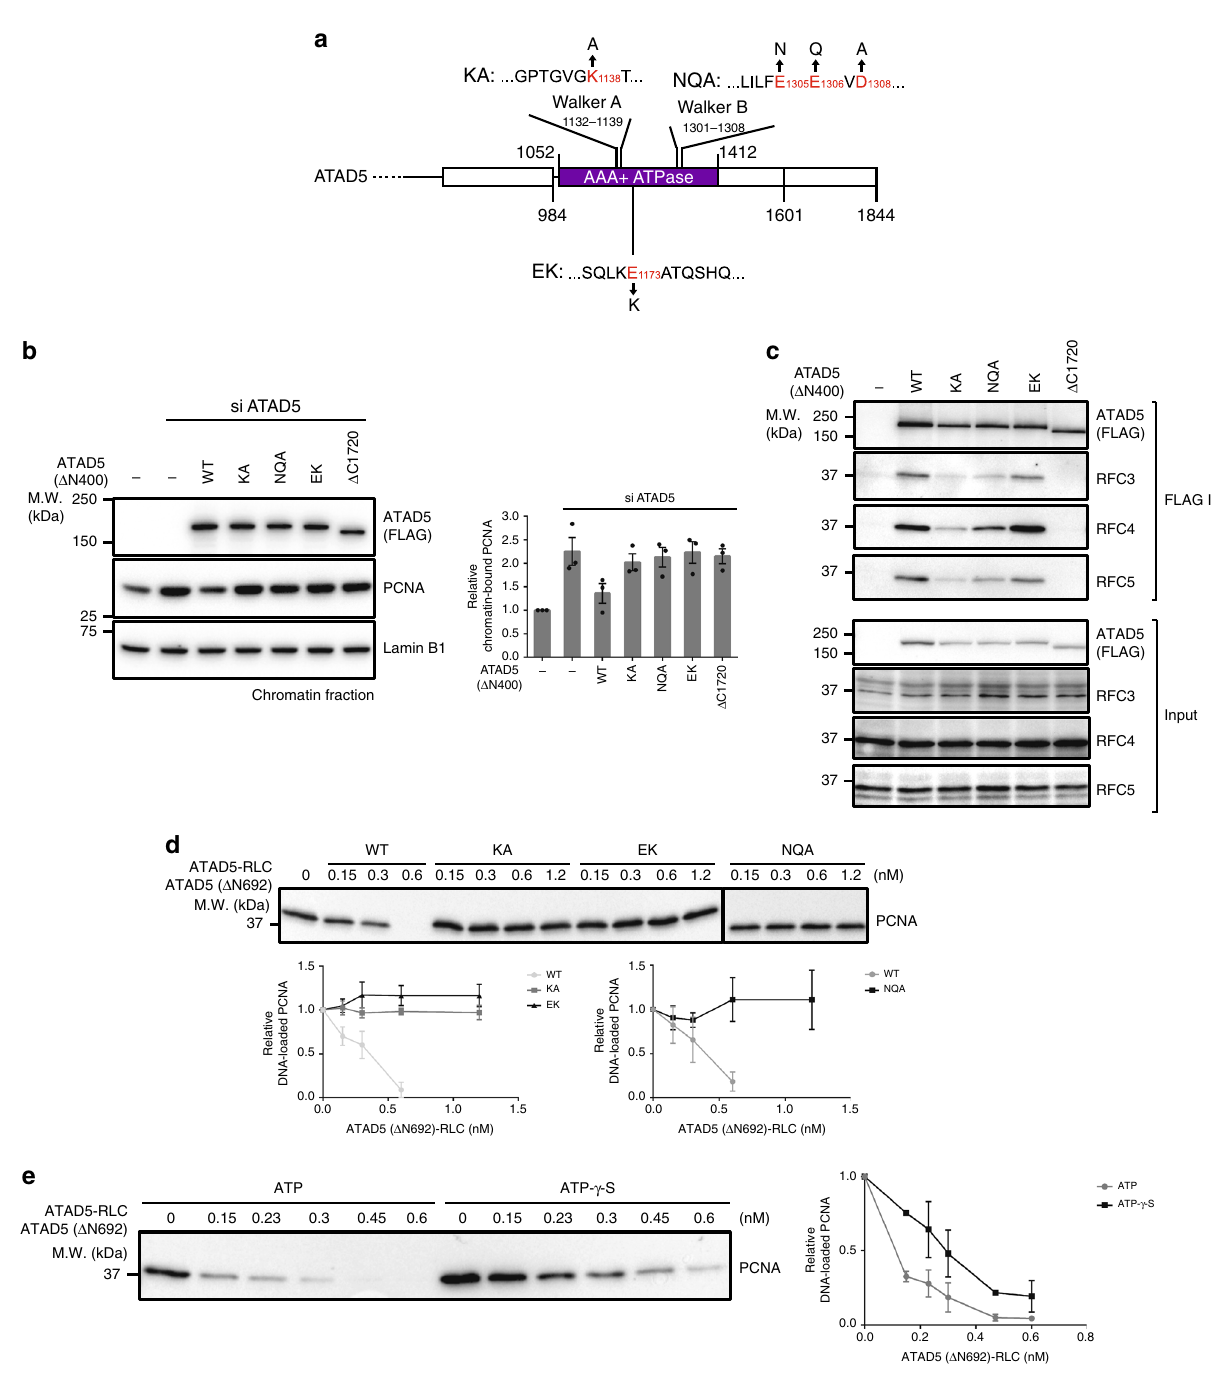
Fig. 3 ATPase interface of ATAD5 is crucial for PCNA unloading. a ATPase-motif mutants examined in this study. Conserved lysine (K1138) in the Walker A motif or negatively charged amino acids in the putative Walker B motif (E1305, E1306, and D1308) were mutated as indicated (denoted as KA and NQA, respectively). E1173K mutation (EK) is located in the conserved region between Walker A and Walker B motifs. b ATPase-motif mutants are defective in PCNA unloading. ATAD5 ( Δ N400) harboring mutations in the ATPase-motif were expressed in ATAD5-depleted 293T cells. Graph shows relative amount of PCNA on the chromatin ( n = 3). The amount of PCNA on the chromatin shows that all ATPase-motif mutants are defective in PCNA unloading, similar to the RBM-deleted mutant (ATAD5 ( Δ C1720)). c Functional Walker A and Walker B motifs are required for stable interaction between ATAD5 and RFC2 – 5. The indicated ATAD5 variants were af fi nity-puri fi ed and co-immunoprecipitated RFC3 – 5 were examined. The KA and NQA mutants show reduced RFC2 – 5 binding compared with wild-type and EK mutant. d ATPase-motif mutants of ATAD5-RLC fail to unload PCNA in vitro. Unloading activity of puri fi ed wild-type or mutant ATAD5-RLC was examined. In total, 1.4 kbps DNA was used for this assay. Graph shows relative PCNA amounts remained on DNA after unloading reaction ( n = 3 for KA and EK experiments and n = 2 for NQA experiments. NQA experiments share control reaction with ATAD5 (693 – 1719) experiments (Fig. 2g), because two experiments were performed together). e ATP- γ -S partially reduces the ef fi ciency of PCNA unloading by ATAD5-RLC. The PCNA unloading reaction was performed in the presence of ATP or ATP- γ -S. In total, 1.4 kbps DNA was used for this assay. Graph shows relative PCNA amounts remained on DNA after unloading reaction ( n = 2). See also Supplementary Fig. 3